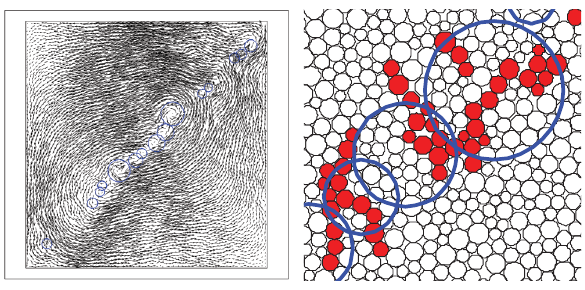
Figure 1. A representative displacement vector field during un- jamming in the limit state showing the shear band (left); a close- up view of buckling force chains shown here by the red colored grains (right). Displacement vectors in vortices, identified and characterized in [8], are highlighted by the blue